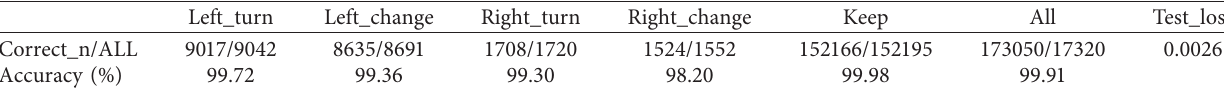
Figure 4: Training process of behavior recognition model. (a) Loss change of behavior recognition model. (b) Accuracy change of behavior recognition model. Table 1: Test results of the behavior recognition